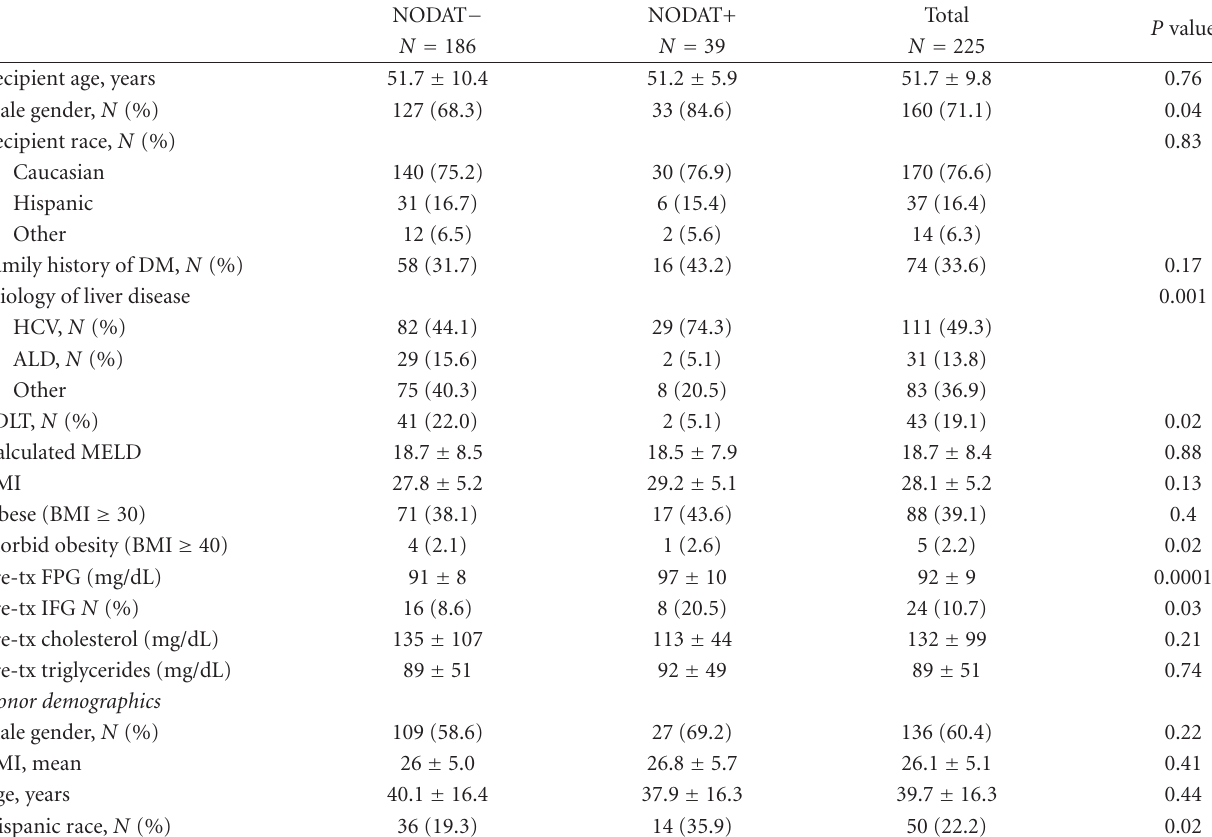
Table 1: Pretransplant demographics by development of NODAT.